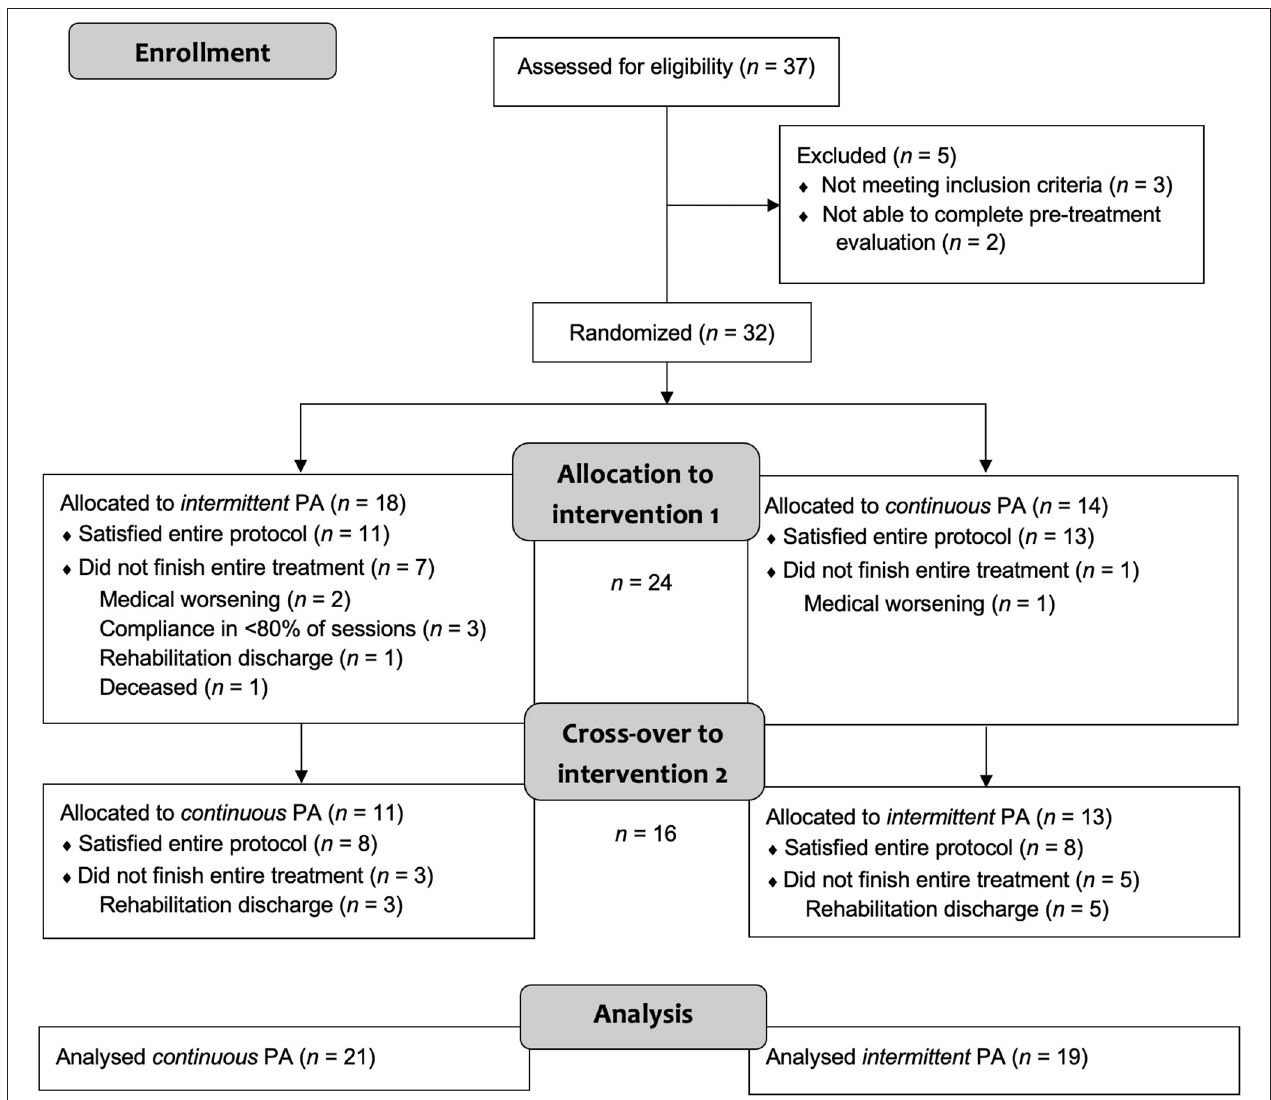
FIGURE 1 | Flowchart of the sample over the course of the study (both recruitment